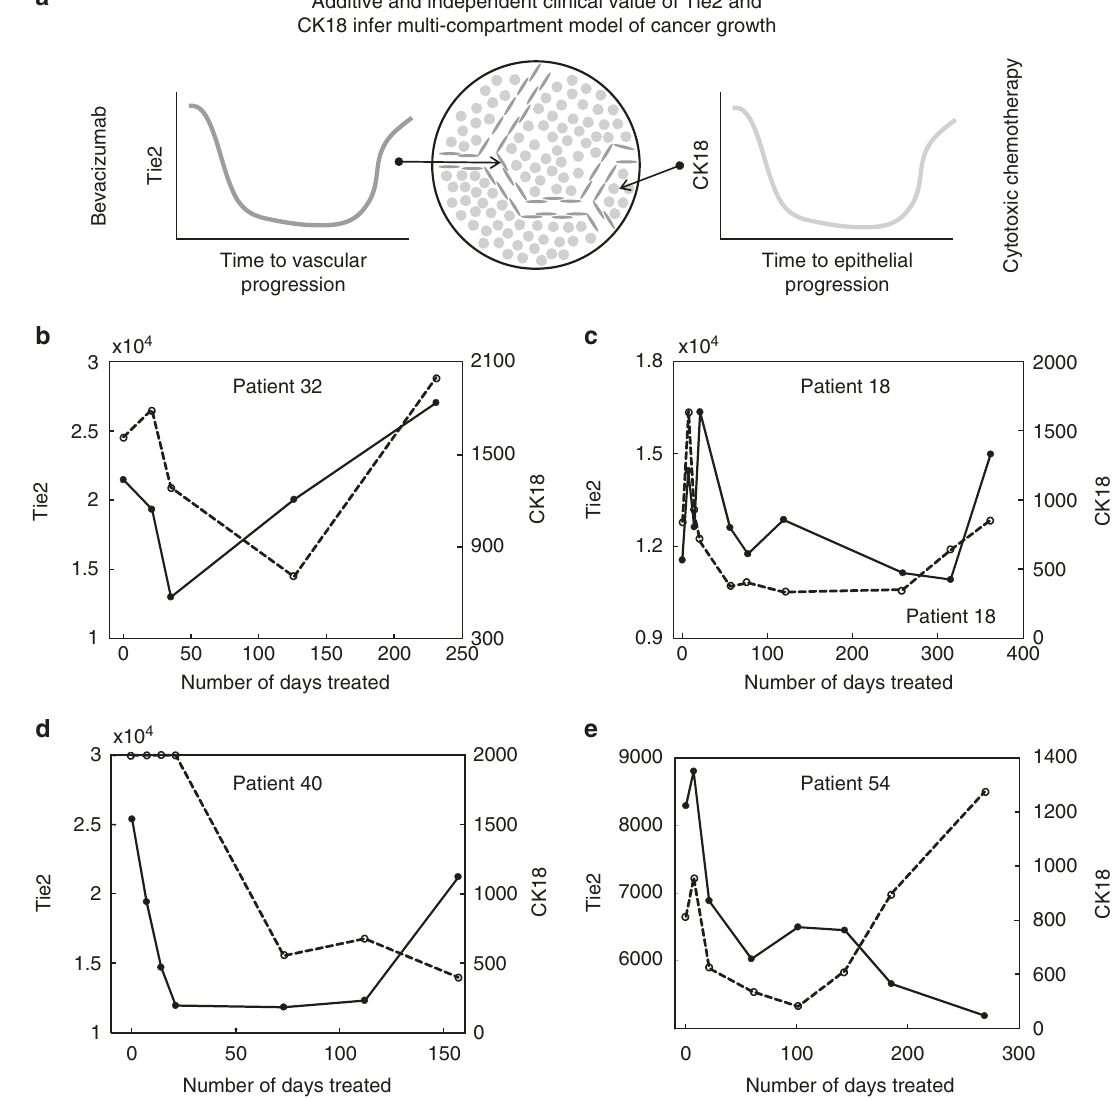
Fig. 6 The tissue multi-compartment model of cancer treatment. a The biomarker data show that Tie2 is a tumor response biomarker for VEGFi and that the predictive value of vascular biomarker data adds to epithelial biomarker data to improve modeling of progressive disease. Together with our previous data in ovarian cancer, the implication of these fi ndings is that the vascular and epithelial compartments are distinct, valid and useful concepts in the treatment of each recurrence of solid tumors. Examples of individual patient data are shown in b – e ; the x -axis represents the number of days that the patient received treatment until they developed RECIST-de fi ned progression (i.e., total tumor burden), Tie2 data are shown as solid black lines and CK18 in dotted black lines. The units for both biomarkers are pg/ml. In b Patient 32 has undergone an epithelial response, vascular response, epithelial progression, and vascular progression. In c , the patient had an epithelial response but not a vascular response thus the patient could have stopped bevacizumab after ~8 weeks of treatment. The patient subsequently had epithelial and vascular progression. In d the patient had an epithelial and vascular biomarker response and then developed vascular progression but not epithelial biomarker progression. In e the patient attained an epithelial and vascular response with subsequent epithelial progression but not vascular progression, suggesting that the vasculature was still controlled at the point of RECIST progression. CK18; cytokeratin 18, VEGFi; vascular endothelial growth factor inhibitor, RECIST; response evaluation criteria in solid